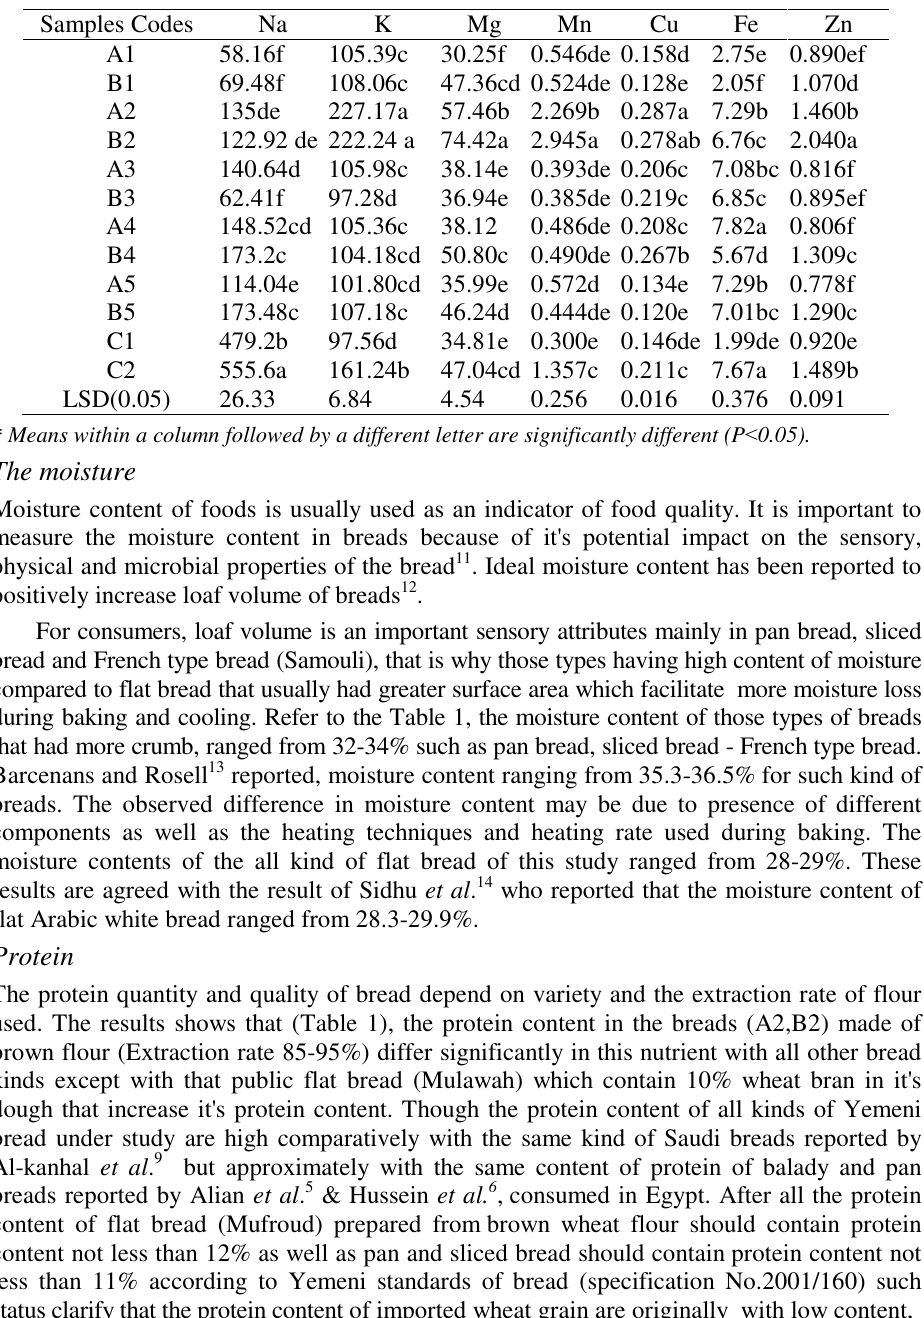
Table 2. The mineral contents of various